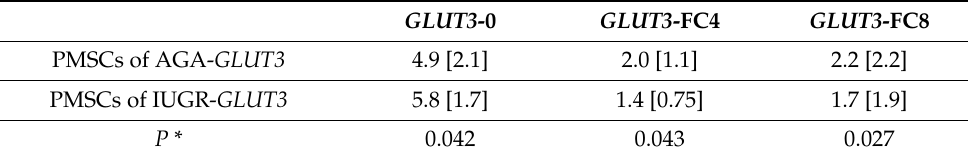
GLUT3 -0: GLUT3 gene expression at normal oxygen concentration culture. GLUT3 -FC4: GLUT3 gene expression fold changes after four hours of hypoxia culture. GLUT3 -FC8: GLUT3 gene expression fold changes after eight hours of hypoxia culture. Gene expression at normal culture are expressed as relative GLUT3 gene expression comparing to GAPDH gene expression ( GLUT1 / GAPDH ). GLUT3 -FC4 and GLUT3 -FC8 are expressed as gene expression after four (eight) hours of hypoxia/gene expression at normal oxygen culture. Data are expressed as median [inter-quartile range]. P *: p value of FCs between PMSCs of AGA and sIUGR fetuses after four or eight hours of hypoxia culture. p values are generated by Wilcoxon signed-rank